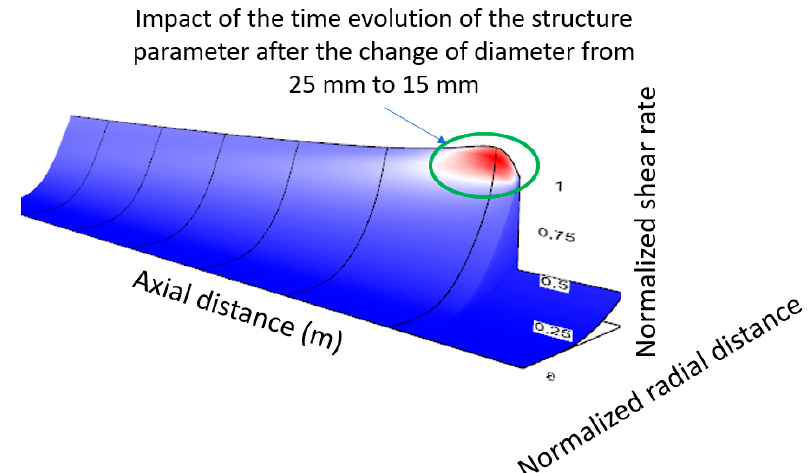
Figure 19. The result of the time evolution of the structure parameter at different radial positions after the change in diameter is axial evolution of the shear rate (here normalized). The color scale is gradient based.